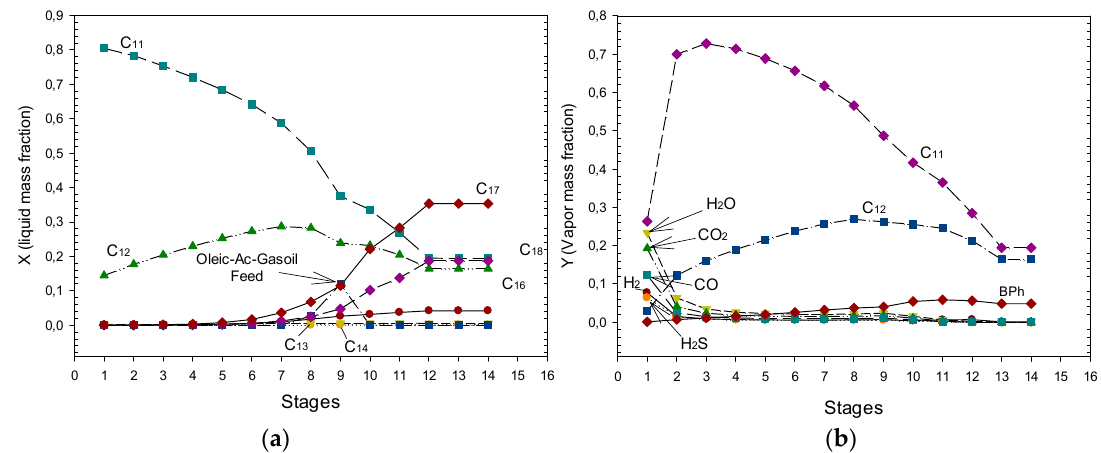
Figure 7. ( a ) RDC profiles for oleic acid-petro-diesel blend fed at stage 9 at 30 atm. ( b ) Gas compositions profile along the RDC. Reproduced with permission from García-Sánchez et al., Proceedings of the